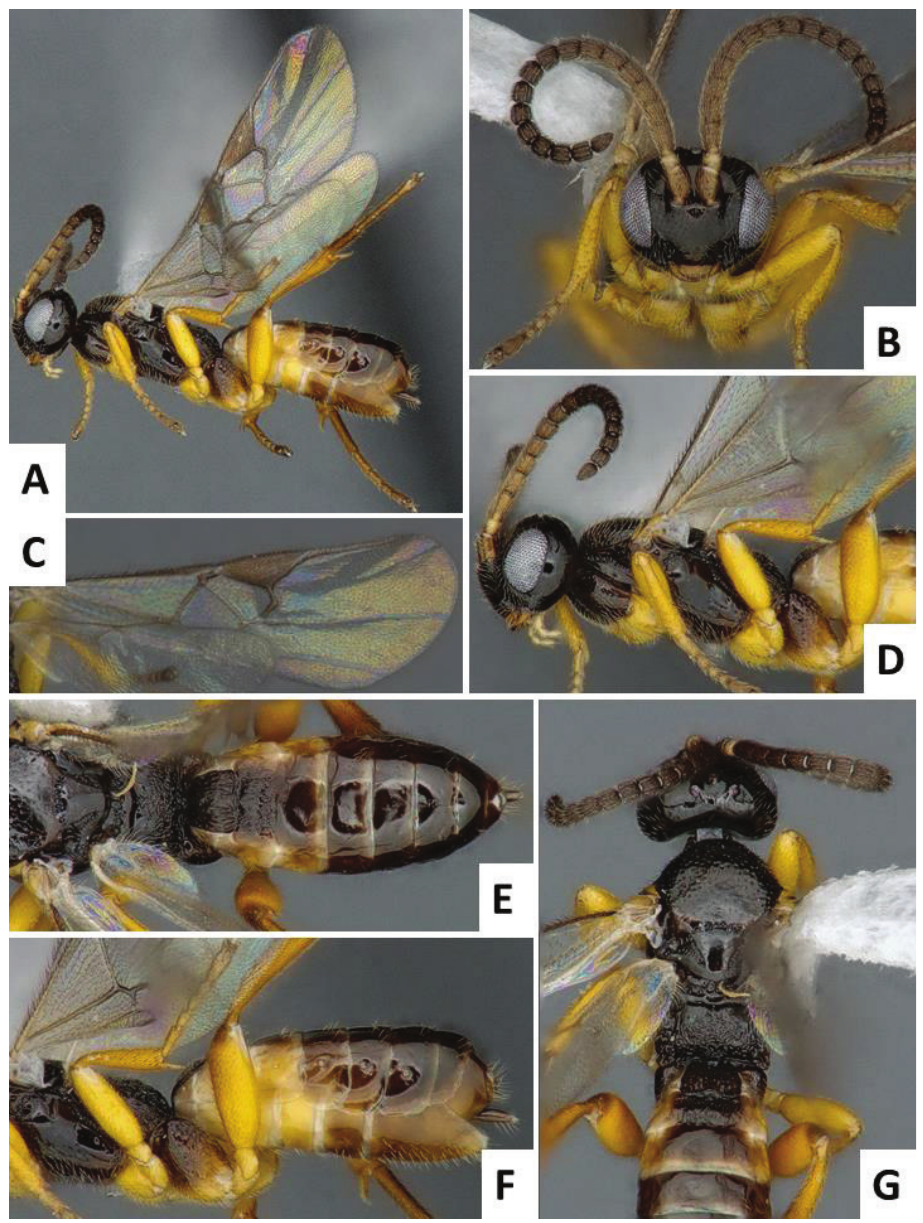
Figure 5. Cotesia sesamiae , female specimen from Kitale, Kenya. A Habitus, lateral view B Head, frontal view C Wings D Head and mesosoma, lateral view E Scutellar disc, propodeum and metasoma, dorsal view F Mesosoma and metasoma, lateral view G Head, mesosoma and tergites 1-4, dorsal